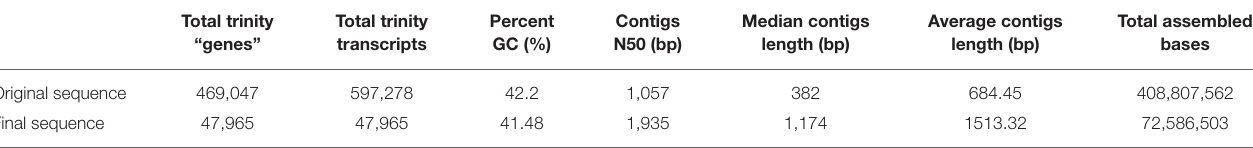
TABLE 1 | Overview of the differentially expressed unigenes of K. sieversiana .